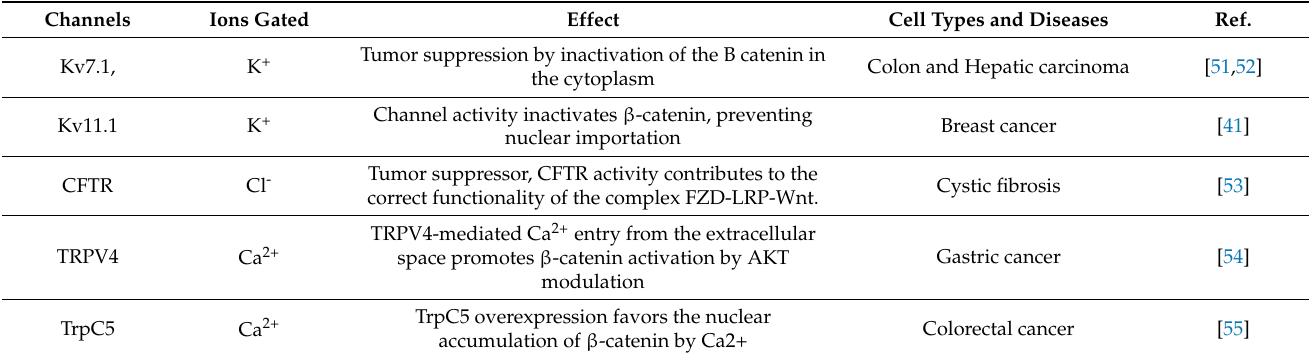
Table 1. Ion Channels involved in Wnt